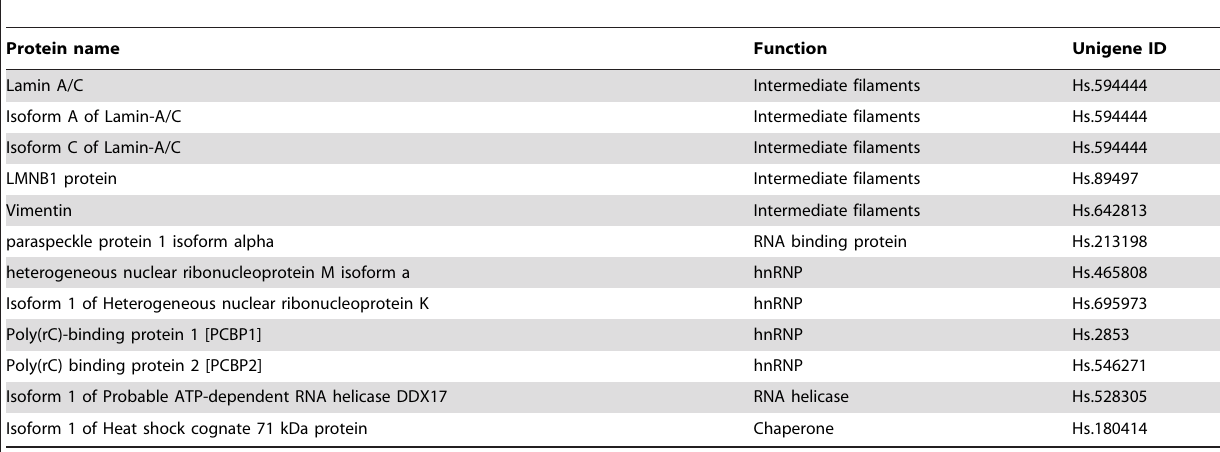
Table 1. Major proteins that differentially bind the S1516 element of the Cx43 3 9 UTR in NIH3T3 neo versus NIH3T3 Ras cells, as identified by LCMS-MS.